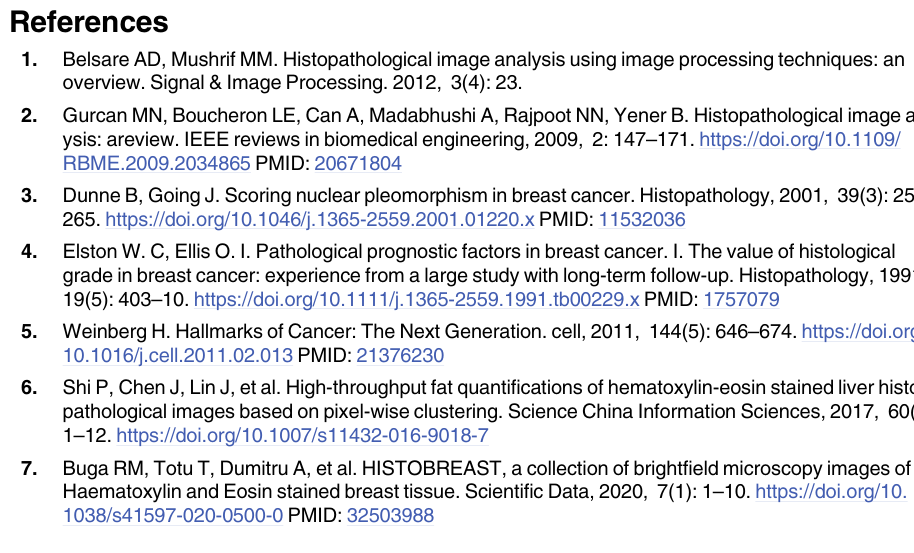
S5 Fig. Our own dataset including original meningioma images 1 to 12. (ZIP) S6 Fig. Our own dataset including original meningioma images 13 to 24. (ZIP) S7 Fig. Our own dataset including original meningioma images 25 to 36. (ZIP) S8 Fig. Our own dataset including original meningioma images 37 to 48. (ZIP) S9 Fig. Our own dataset including original meningioma images 49 to 60.